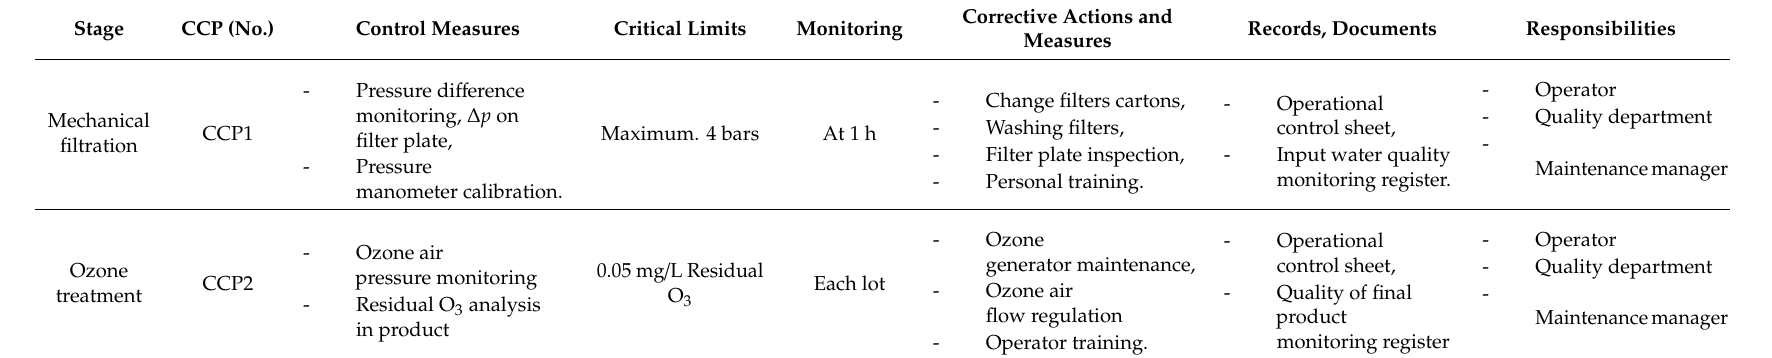
Table 12. Control measures, critical limits, monitoring procedures, corrective actions and documents for each